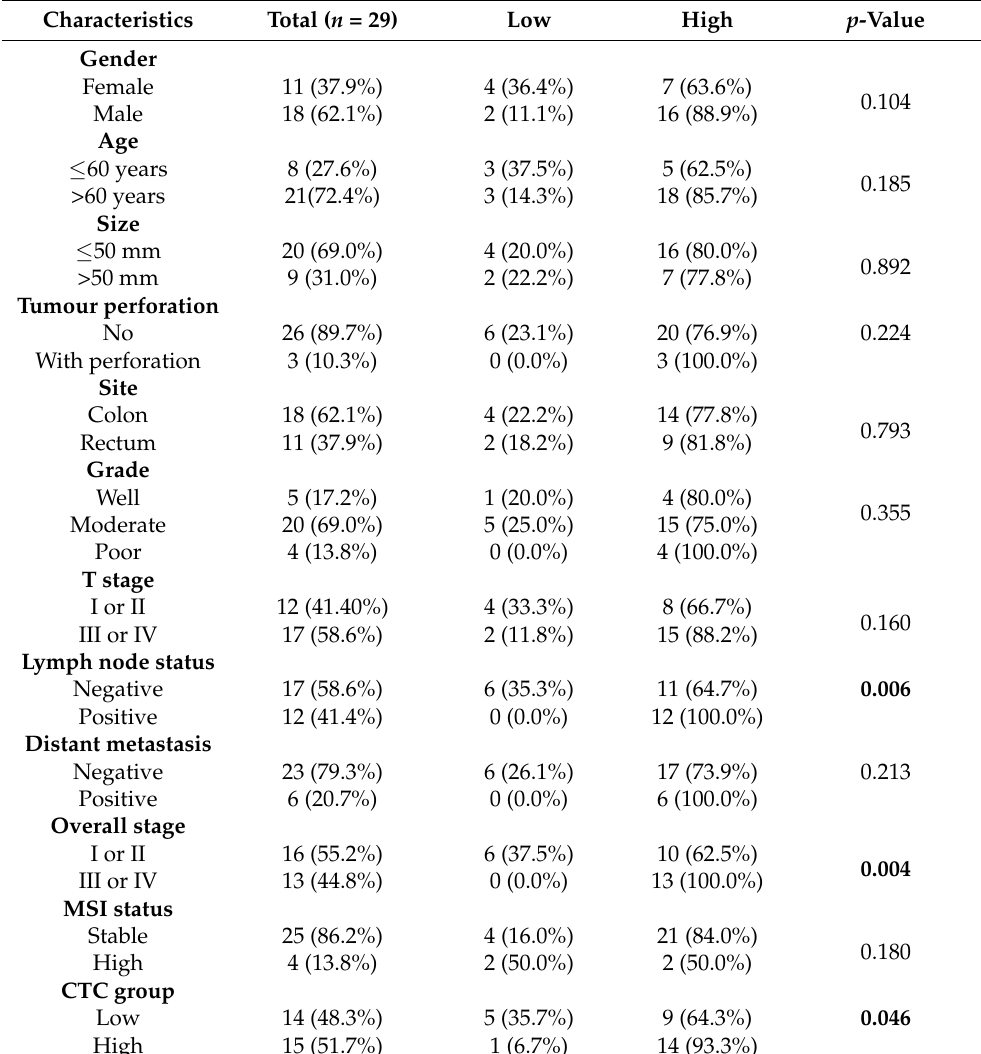
Table 3. The correlations of CTLA-4 gene expression levels in PBMCs with clinicopathological features in patients with colorectal carcinoma